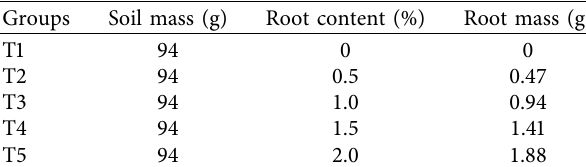
Table 3: Root content test plan.